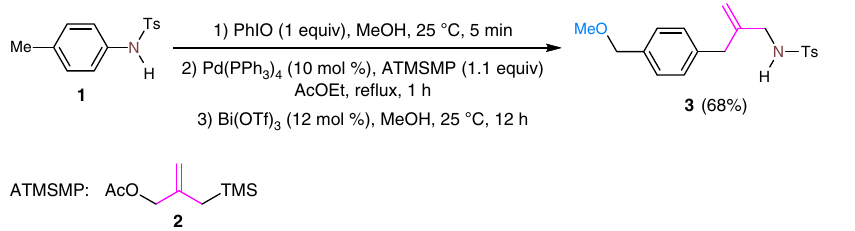
Fig. 2 TMM insertion into aryl carbon – nitrogen bond in p -toluidine concomitant with benzylic methoxylation. Ts tosyl, Ac acetyl, TMS thrimethylsilyl. Trimethylenemethane in pink, which is consistent with the color of FG in Fig.1 means that is insertion group. N in purple is consistent with the color of N in Fig.1. Methoxyl group in corn fl ower blue means that it is a newly